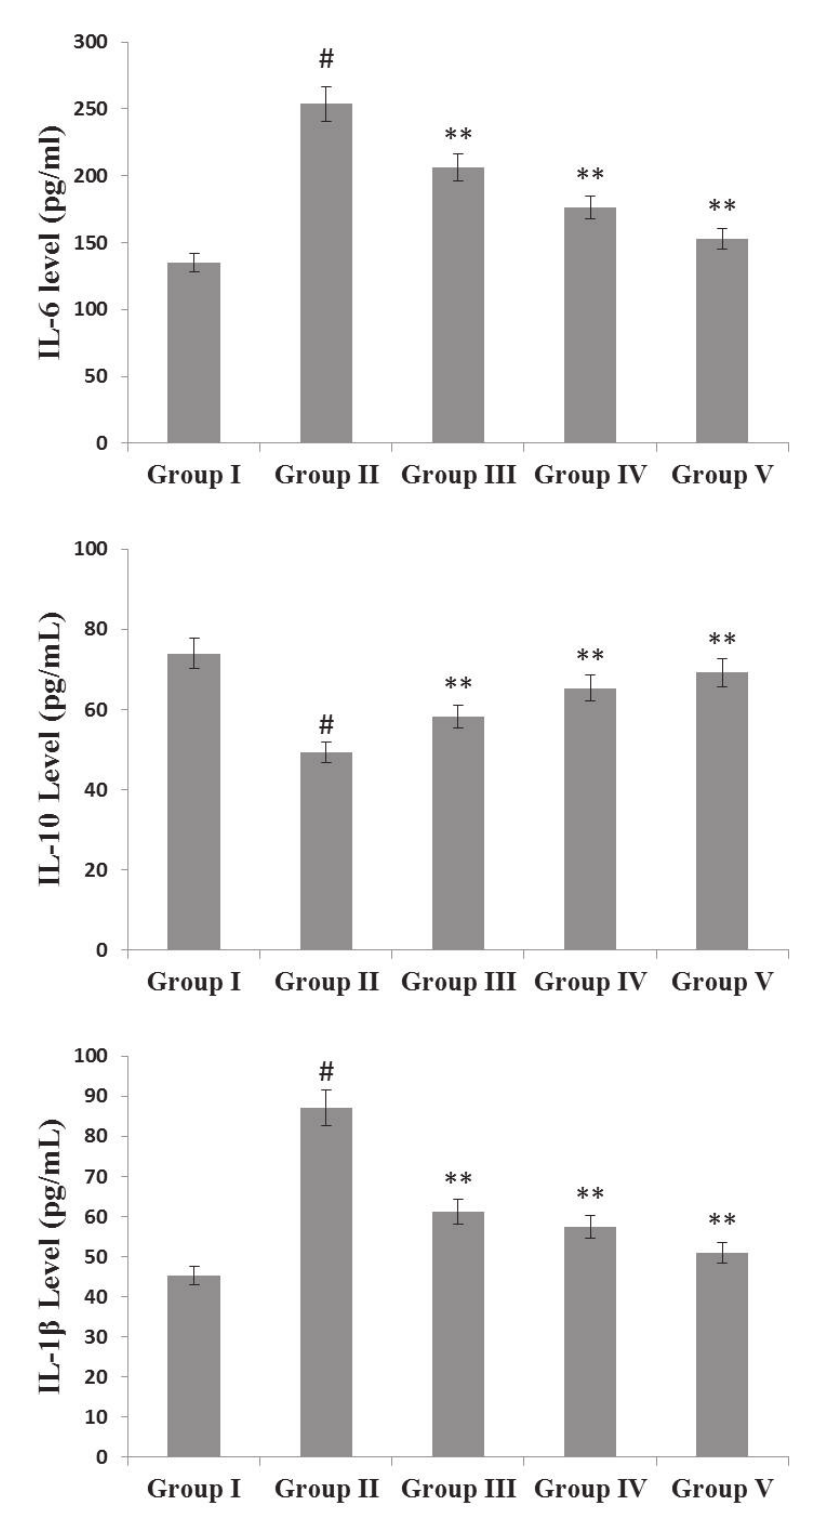
FIGURE 3 - Effect of ginkgolic acid on the levels of inflammatory cytokines in CFA-induced arthritic rats. (A) Effect on the levels of TNF- α ; (B) Effect on the levels of IL-6; (C) Effect on the levels of IL-10; (D) Effect on the levels of IL-1 β . Values expressed as mean ± SEM (n = 8) and analyzed by one-way ANOVA followed by Tukey’s multiple comparisons test. # p < 0.05 as compared to normal control group I. ** p < 0.01 as compared to CFA group